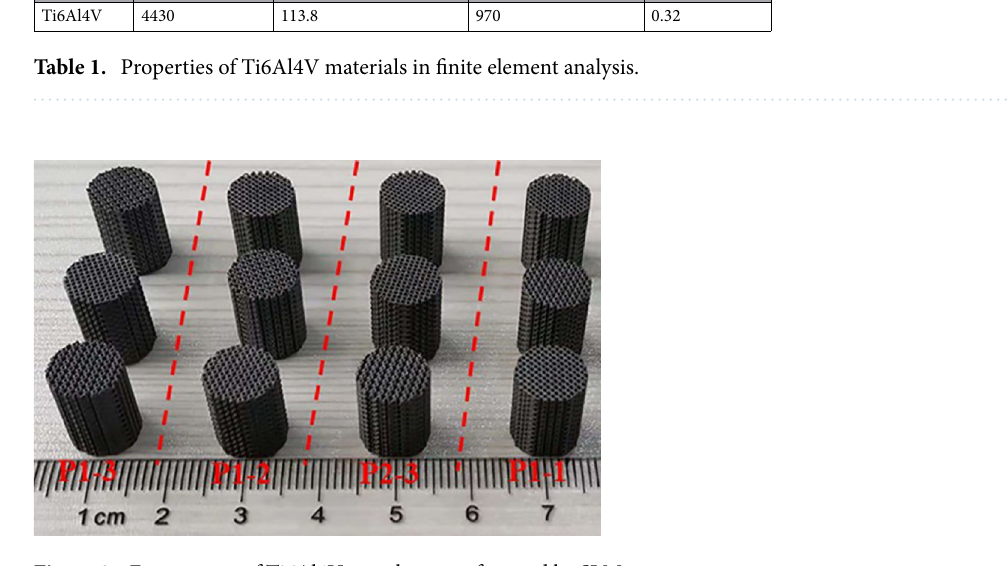
Figure 3. Four groups of Ti6Al4V samples manufactured by